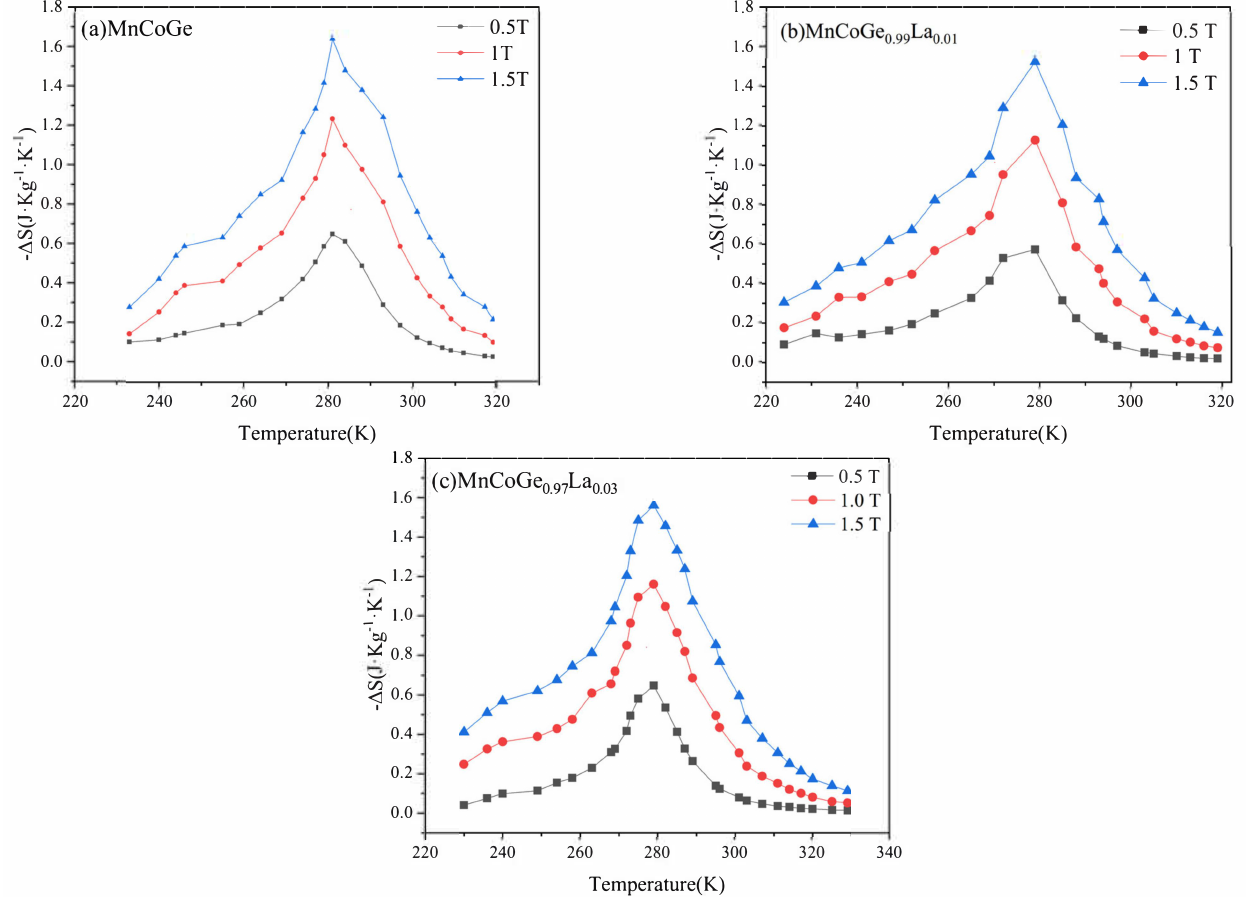
Figure 9. Temperature dependence of the magnetic entropy changes at different amplitudes of change in the applied